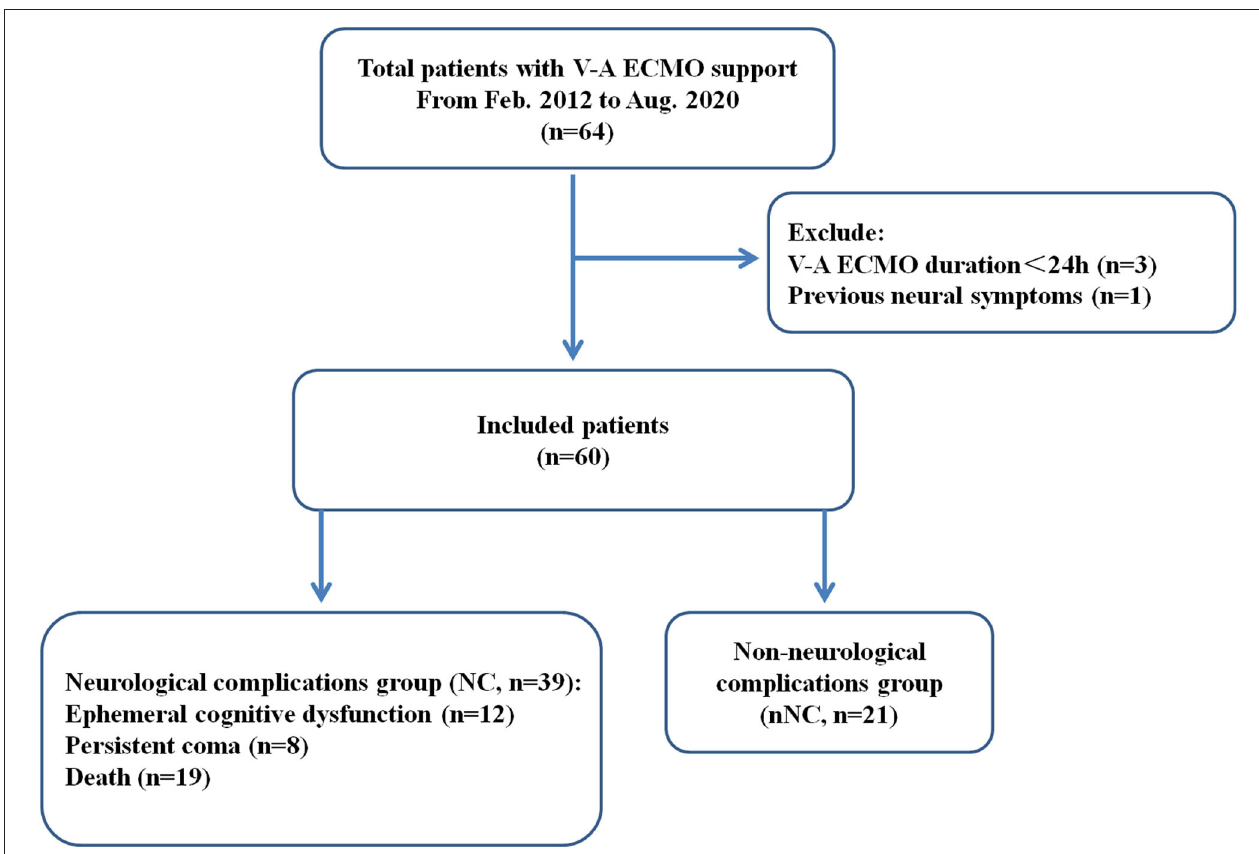
FIGURE 1 | Flow chart of patient cohorts. V-A ECMO, veno-arterial extracorporeal membrane oxygenation; NC, neurological complications group; nNC, non-neurological complications